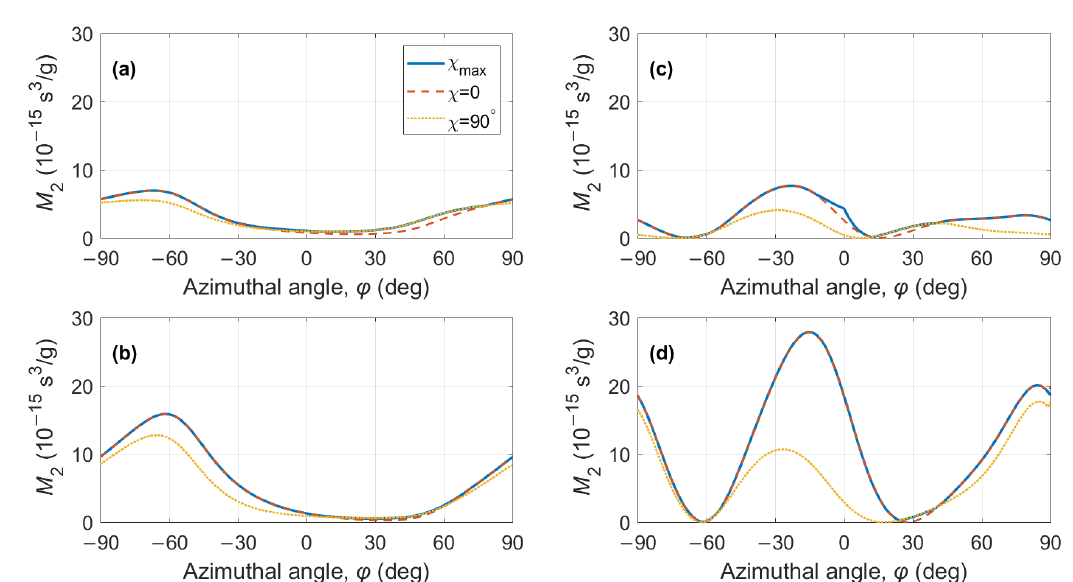
Figure 7. KGW crystal, AO figure of merit for acoustic propagation on the XY plane ( θ = 90 ◦ ): ( a ) QL BAW mode, fast optical mode; ( b ) QL BAW mode, slow optical mode; ( c ) QS BAW mode, fast optical mode; ( d ) QS BAW mode, slow optical mode. Solid lines—data from Figure 4; dashed and dotted lines—calculation according to Equations